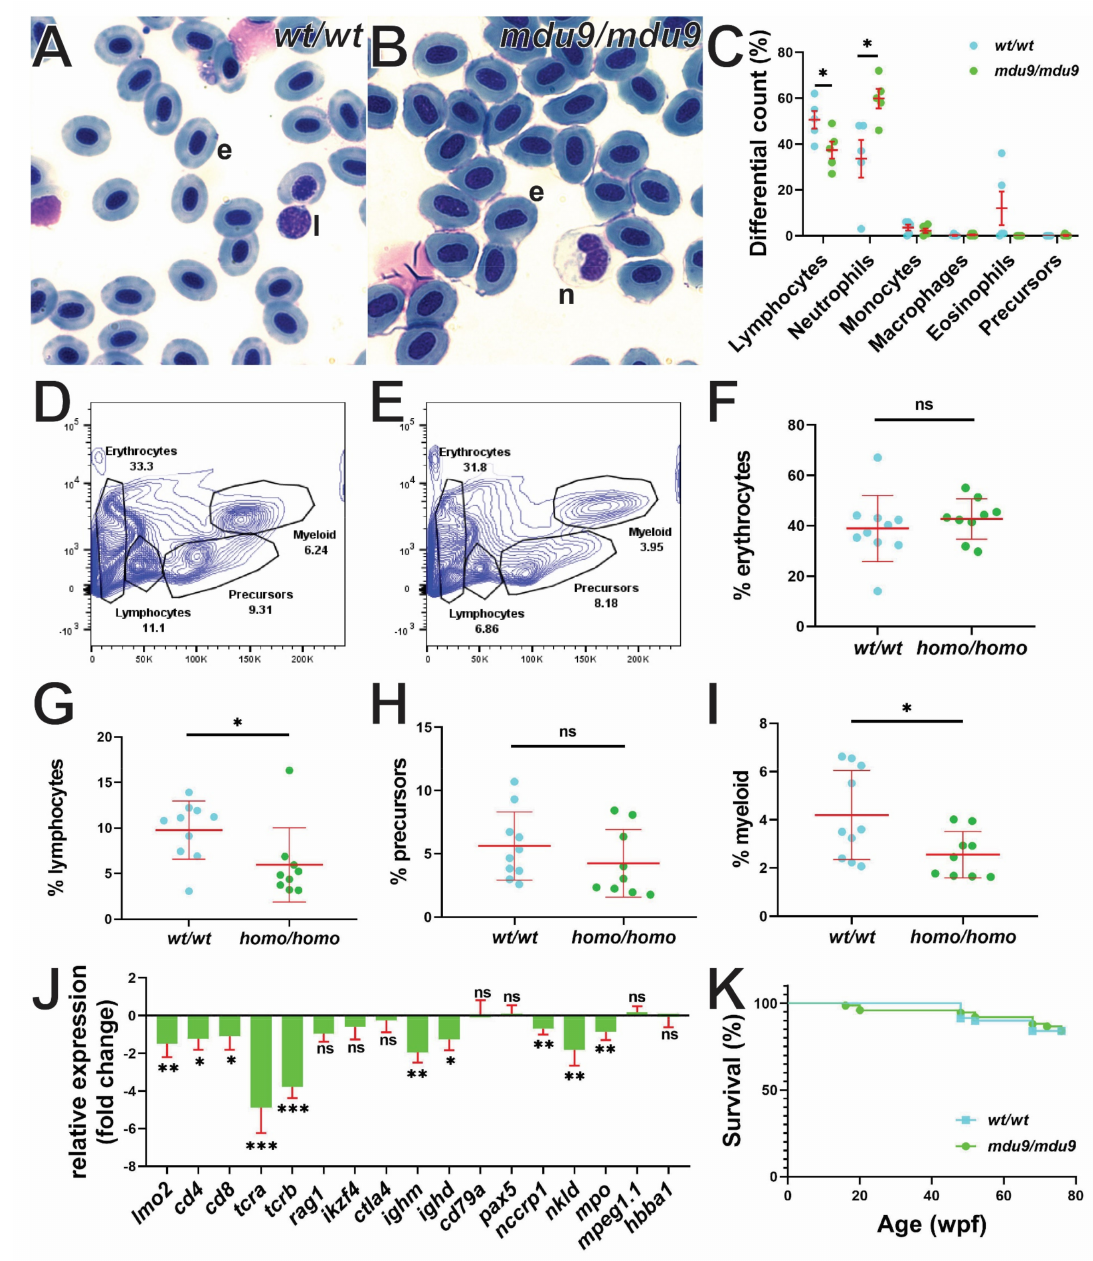
Figure 4. Effect of SCID-derived JAK3 mutations on zebrafish adult hematopoiesis. ( A – C ). Analysis of peripheral blood from adult wild-type ( wt / wt ) ( A ) and mutant ( mdu9 / mdu9 ) ( B ) jak3 fish using Giemsa staining (e: erythrocyte; l: lymphocyte; n: neutrophil), including differential counts of the indicated cell populations ( C ). ( D – I ) FACS analysis of adult kidney from wild-type ( wt / wt ) ( D ) and mutant ( E ) jak3 fish, along with quantitation of erythrocyte ( F ), lymphocyte ( G ), precursor ( H ) and myeloid ( I ) populations in wild-type ( wt / wt ) and mutant ( homo / homo ) individuals as indicated. ( J ) Analysis of hematopoietic cell lineages in adult kidney from wild-type and homozygous mutant fish using qRT 2 -PCR analysis with the indicated lineage cell markers. Data is represented as relative fold change compared to wild-type with mean and SEM shown in red and statistical significance of normalized Cq values (relative to control actb ) indicated (*** p < 0.001, ** p < 0.01, * p < 0.05, ns not significant; n = 6). ( K ) Survival analysis of wild-type and mutant jak3 fish at each week post fertilization (wpf) displayed as a Kaplan–Meier plot ( wt / wt , n = 70, mdu9 / mdu9 , n =